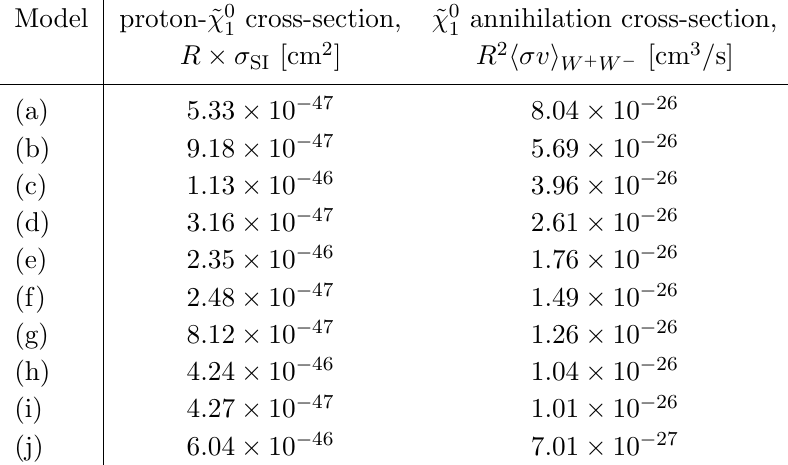
in the W + W (cid:0) W + W (cid:0)